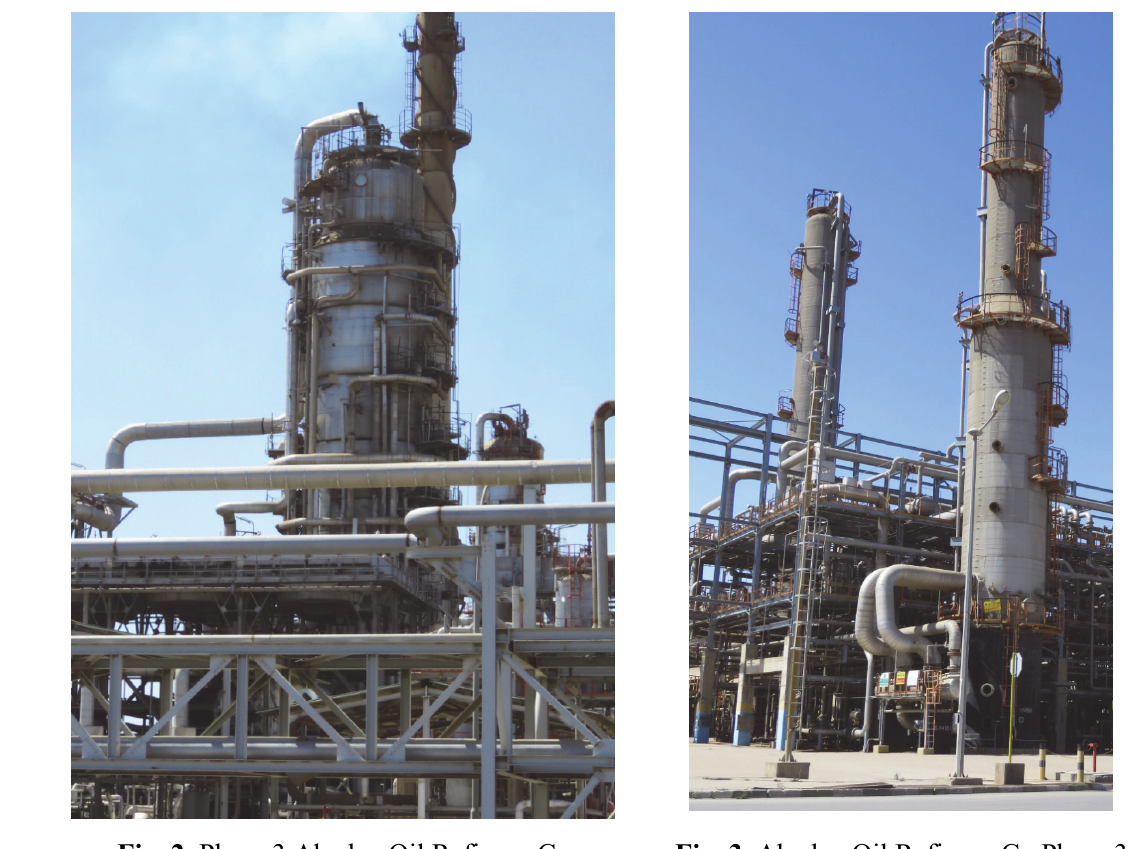
Fig. 2. Phase 3 Abadan Oil Refinery Co Fig. 3. Abadan Oil Refinery Co Phase